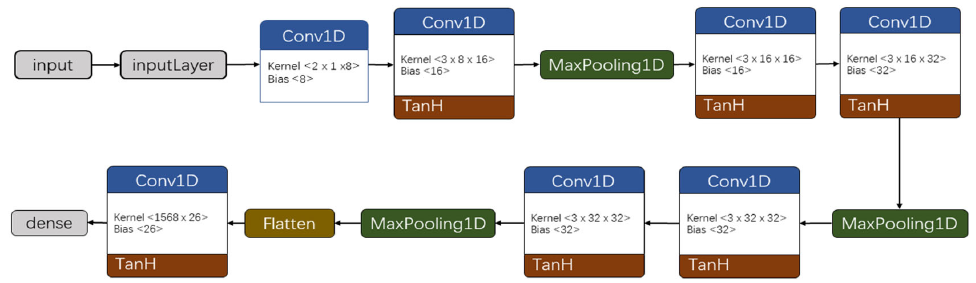
Figure 6. CNN structure implemented for character recognition.